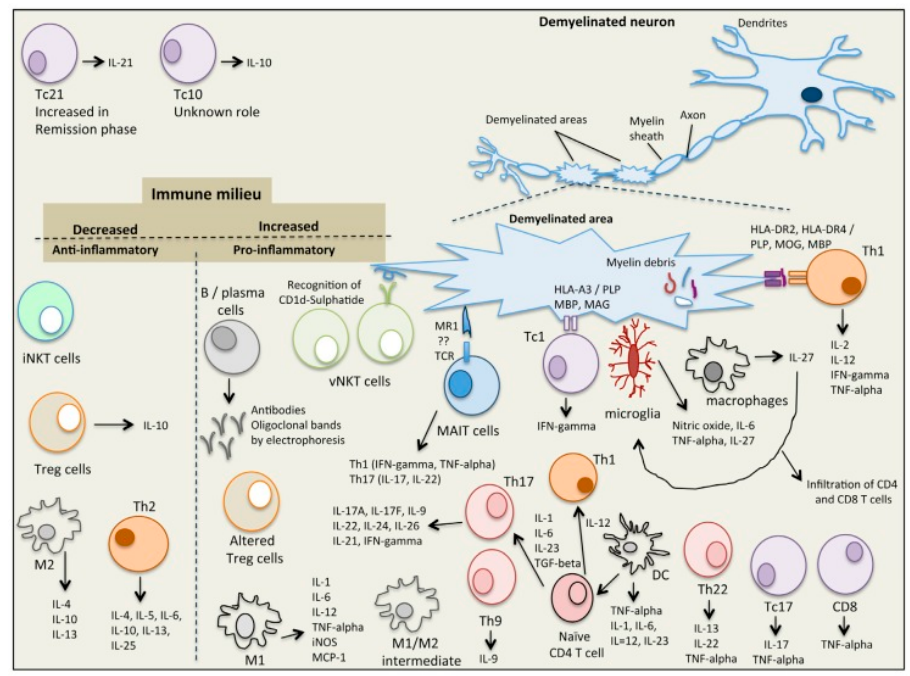
Figure 1. The immunological complexity of the immune / cytokine network in multiple sclerosis (MS). Adapted from Dargahi et al. [25].